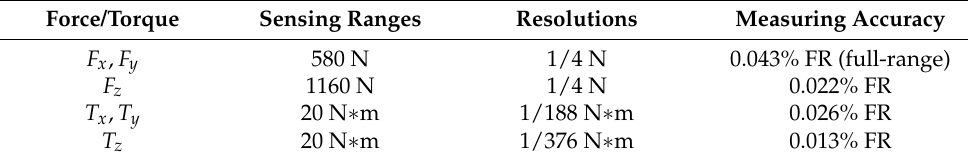
Figure 5. Composition and configuration of the experimental system. ( a ) Mechanical composition of the experimental prototype. ( b ) Cable connection and data flow of the experimental prototype. ( c ) Diagram of the CPG control strategy Adapted from the Ph.D. dissertation of Cao Yong (2015, Beihang University) [28] and definition of the pectoral fin bias. Table 1. Ranges and resolutions of the ATI mini 45 force/torque